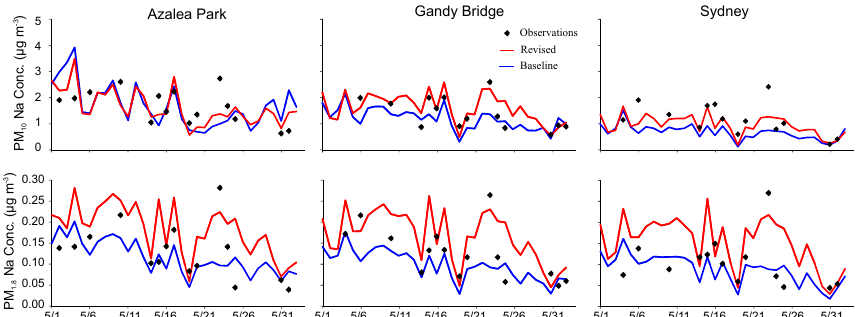
Figure 2. Time series of the observed and predicted daily PM 10 and PM 1 . 8 Na + concentration at the three BRACE sites. Note that the PM 1 . 8 Na + concentration predicted by CMAQ is represented by the sum of the Aitken and accumulation modes. This CSN site is part of the CONUS model evaluation de- scribed in Sect.